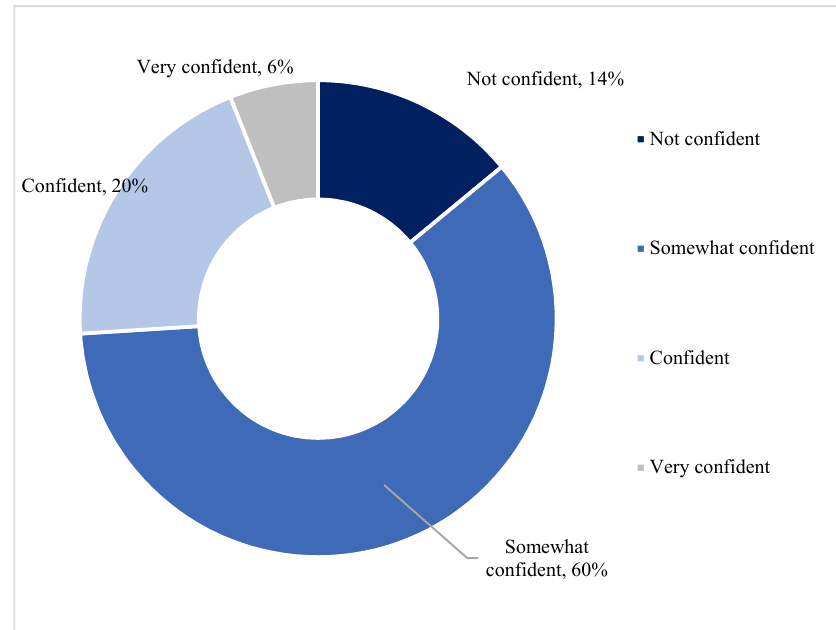
Figure 3. Confidence in the Quality of Tap Water.